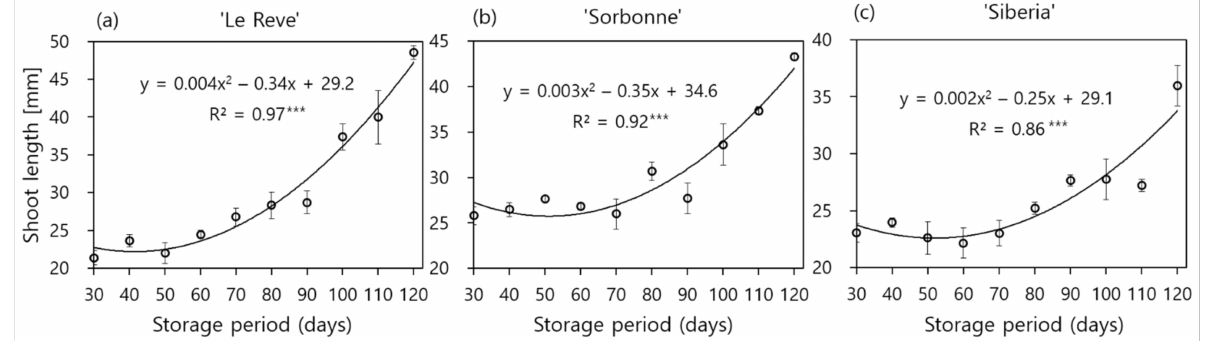
Figure 1. Shoot length measured at the end of each bulb storage period at 0 ◦ C in Lilium Oriental Hybrids ‘Le Reve’ ( a ), ‘Sorbonne’ ( b ), and ‘Siberia’ ( c ). *** Significant at p <